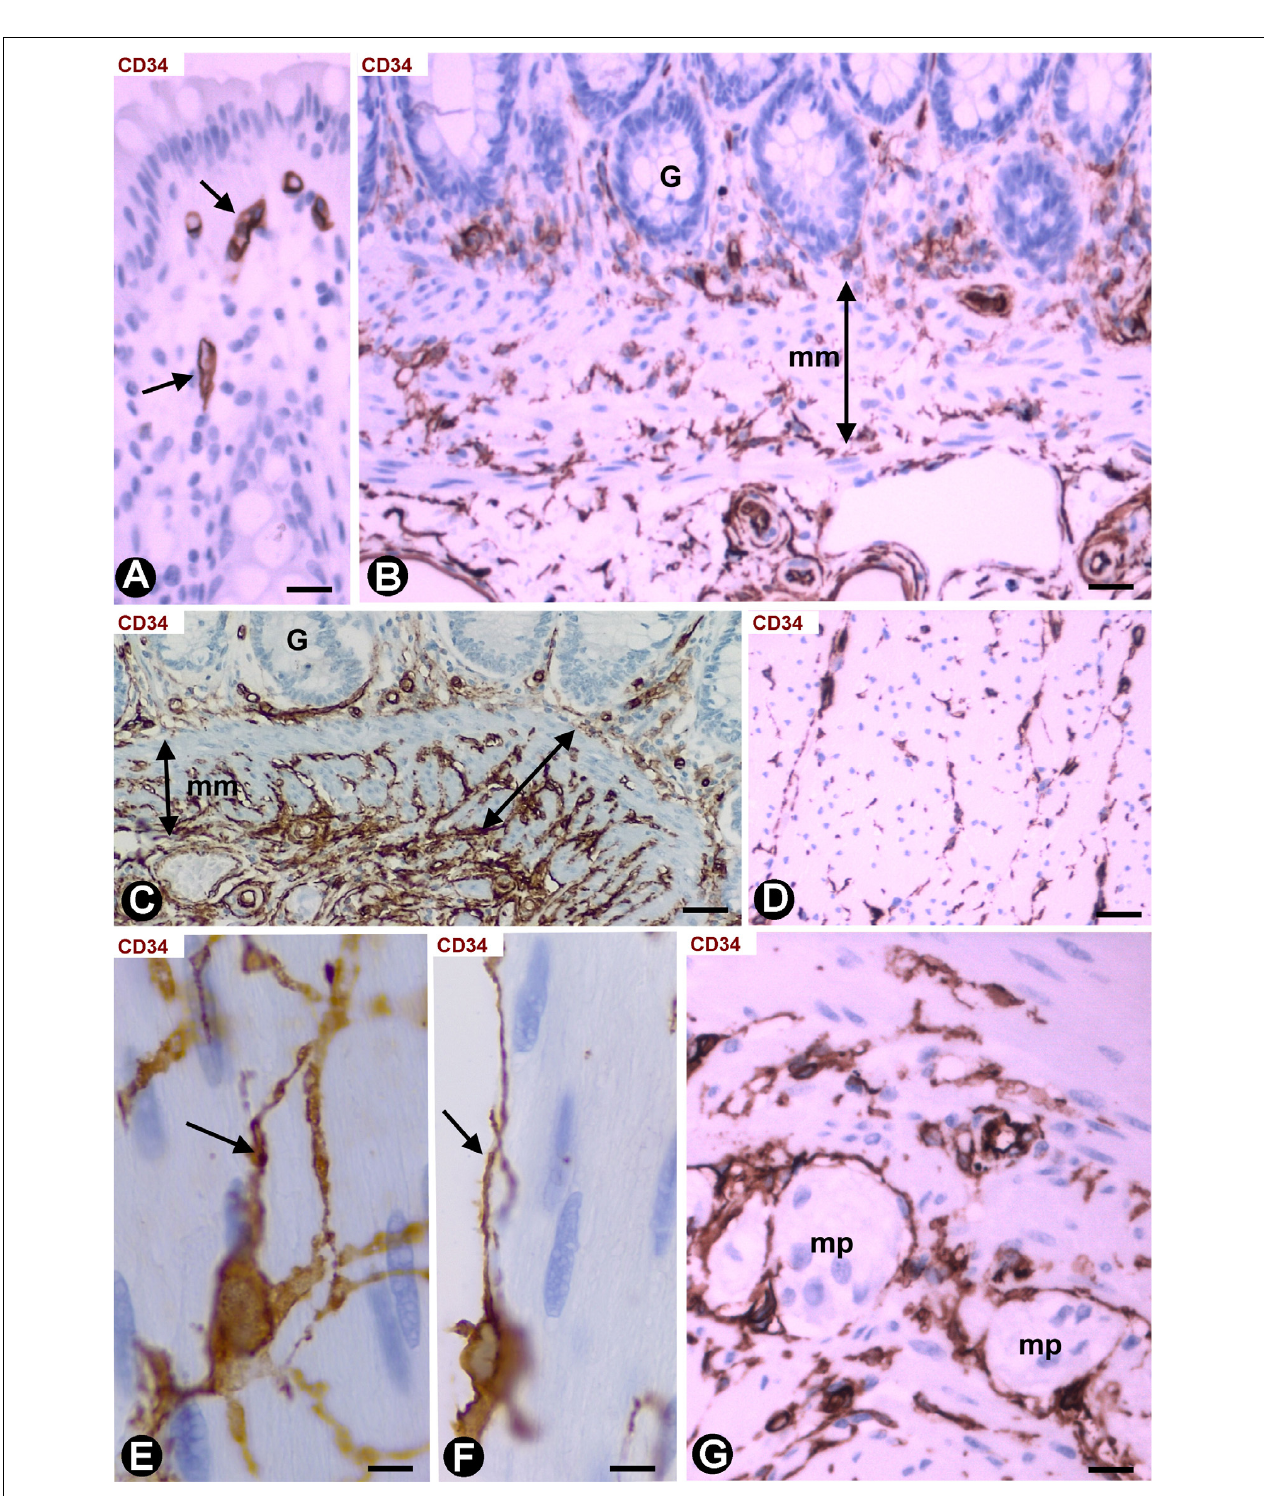
FIGURE 4 | CD34+SCs/TCs in the normal intestinal wall. Sections stained with anti-CD34. (A) Absence of CD34+SCs/TCs in the chorion of the mucosa underlying the epithelium (only the endothelial cells express CD34, arrow). (B,C) Varying numbers of CD34+SCs/TCs (brown) in the areas between the base of the mucosa tubular glands and the muscularis mucosae (mm). A portion of the submucosa with abundant CD34+SCs/TCs (brown) is also observed in panel (C) . (D) CD34+SCs/TCs (brown) are seen within and around the muscle fascicles of the muscularis propria. (E,F) Details of the CD34+SCs/TCs within ( E , arrow) and around ( F , arrow) the muscle fascicles. (G) CD34+SCs/TCs in myenteric plexuses (mp). Bar: (A,G) 20 µ m; (B–D) 40 µ m; (E,F) 10 µ m.